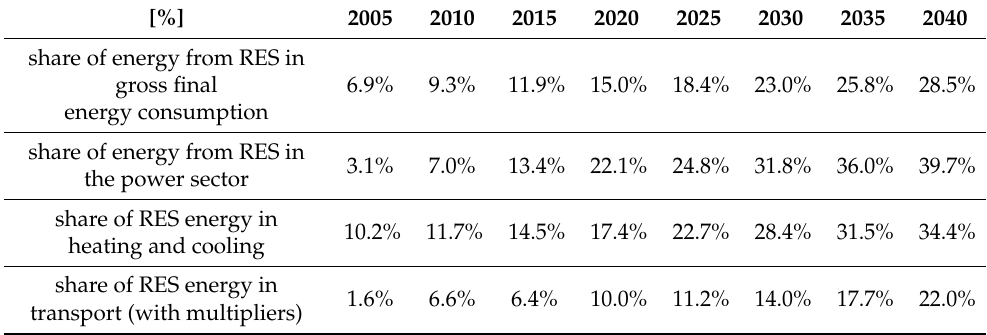
Table 1. Forecast of total and sectoral share of RES consumption—Total and by sector